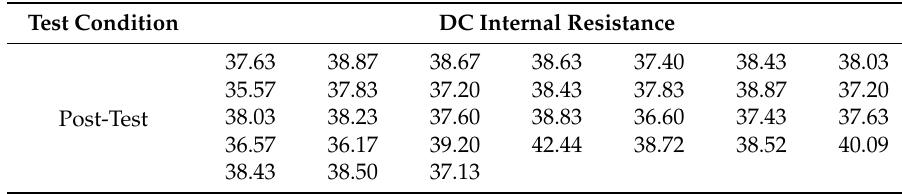
Table 3. DC resistance distribution after vibration test (m Ω ).